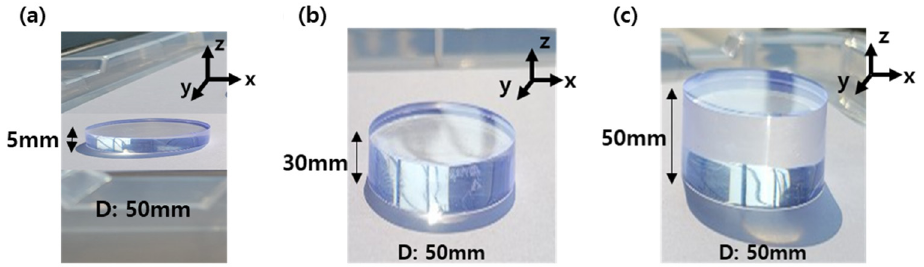
Figure 1. Different volume and thickness plastic scintillators: ( a ) 5 mm thickness; ( b ) 30 mm thickness; ( c ) 50 mm thickness.